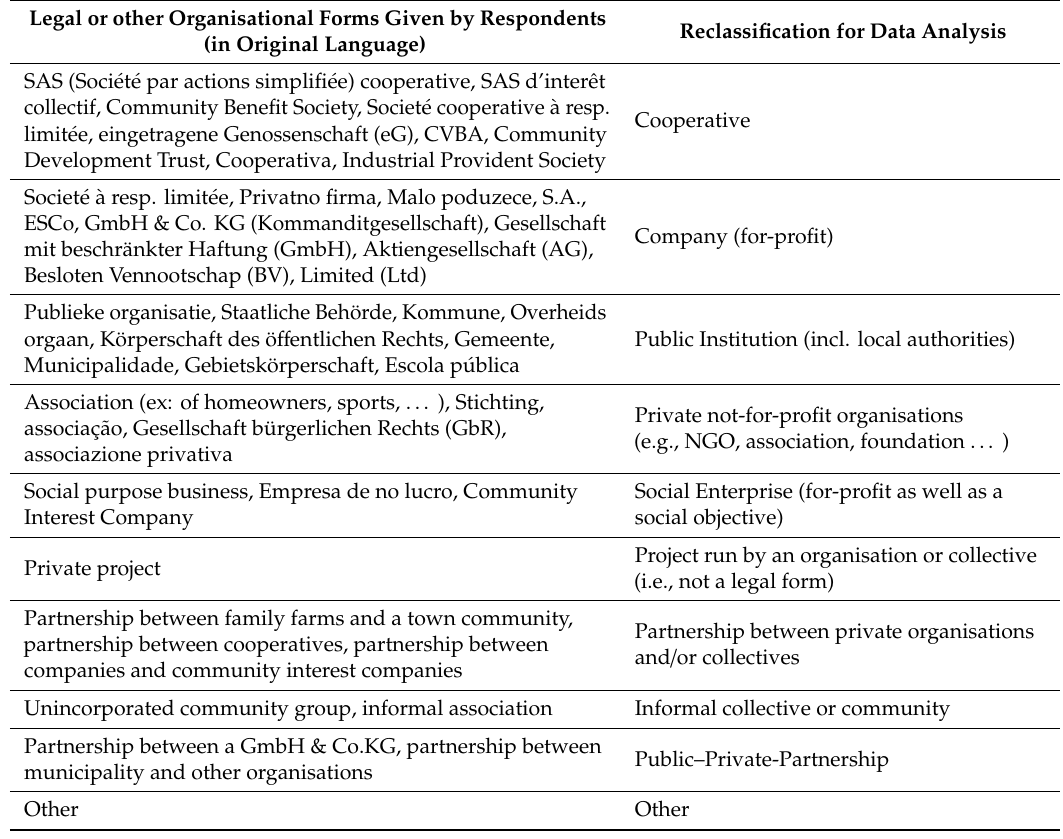
Table 3. Reclassification of 50 + legal and organisational forms reported by survey respondents. Source: [23] (p. 54).